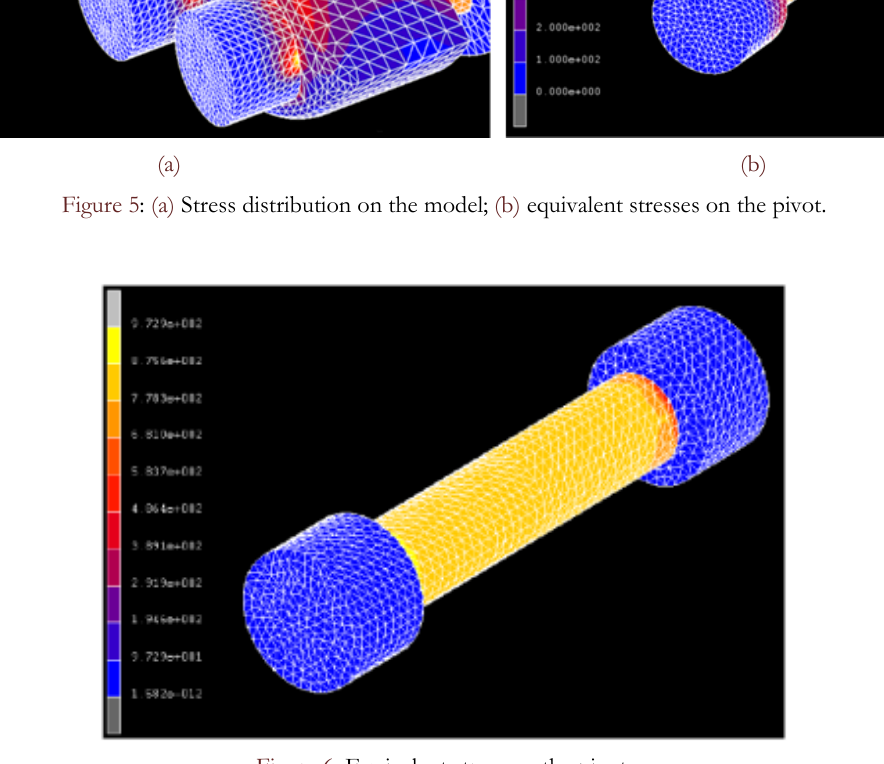
Figure 6: Equivalent stress on the